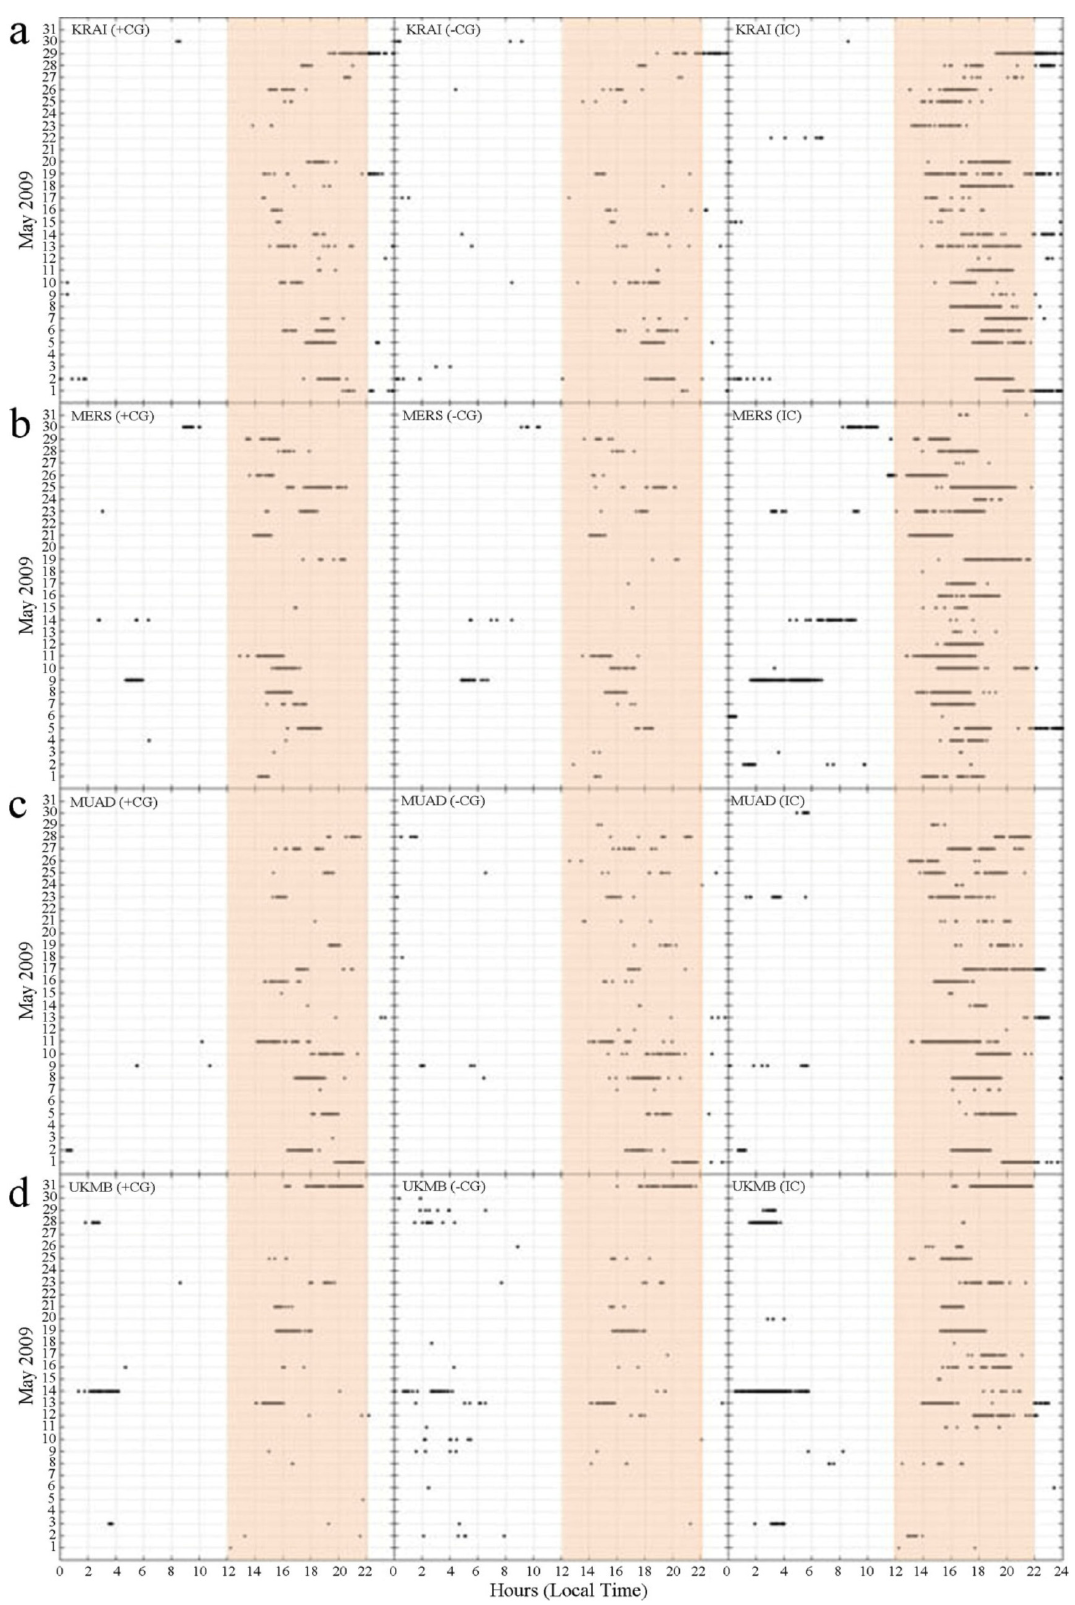
Figure 5. Lightning distribution at four selected stations during the first pre-monsoon (May